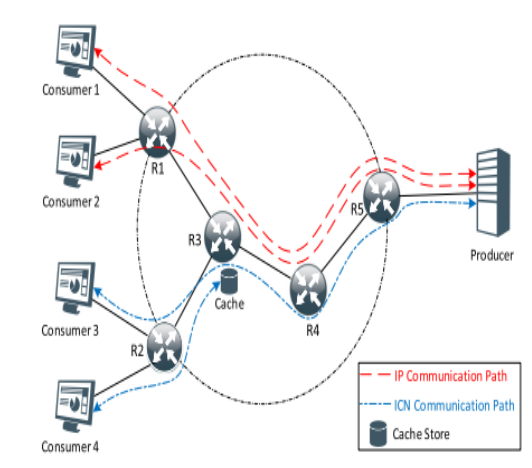
Figure 2. Content Retrieval: IP-based vs. ICN-based